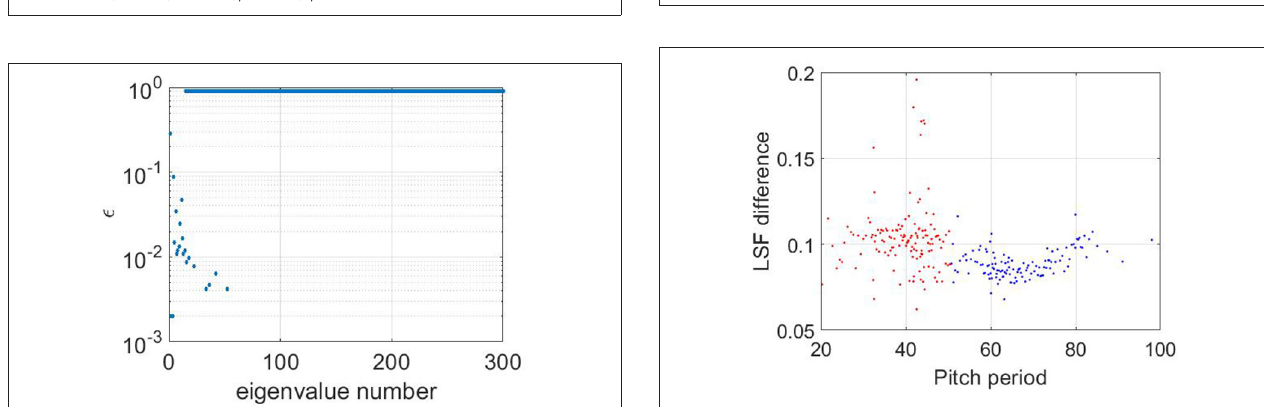
FIGURE 7 | Classification of “three moons” dataset. The values of parameters are n = 300, m = 3, M = 60, p = 0.5, q =0.9.